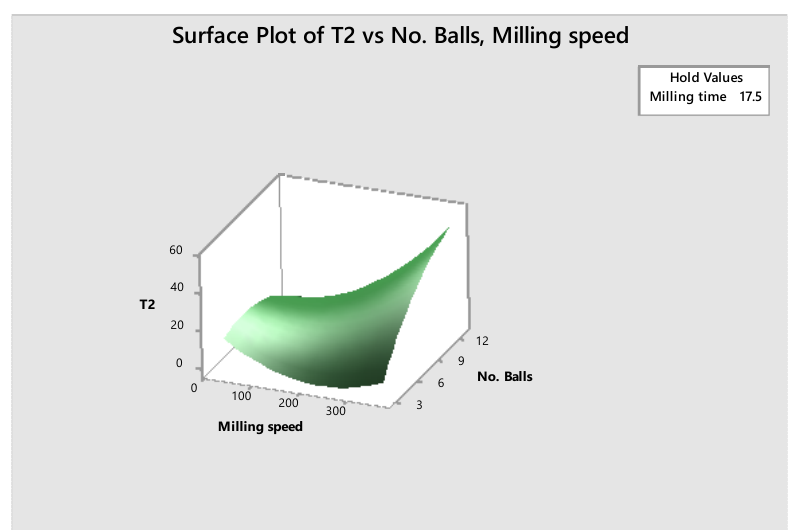
Figure 12. T2 vs. milling speed vs. no. of balls.